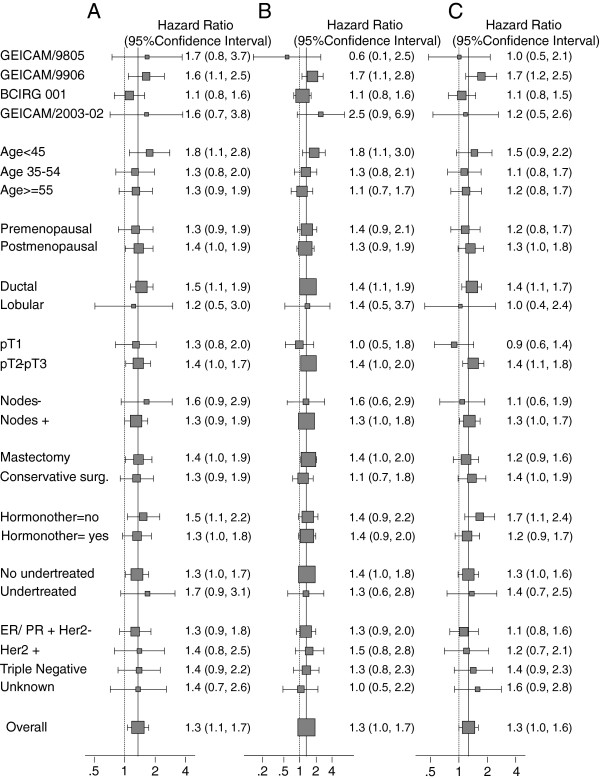
Hazard ratios and 95% CI associated with severe obesity (body mass index ≥35) compared to the reference group (body mass index <25) for each survival outcome by the categories of each covariate. (A) Overall mortality. (B) Breast cancer mortality. (C) Recurrence estimates were adjusted for all the variables in the full model. The size of the interval and the box are proportional to the amount of information available per stratum. GEICAM, Spanish Breast Cancer Research Group; BCIRG, Breast Cancer International Research Group; pT, pathologic primary tumor size; surg, surgery; HER2: human epidermal growth factor-2; ER, estrogen receptor; PR, progesterone receptor.